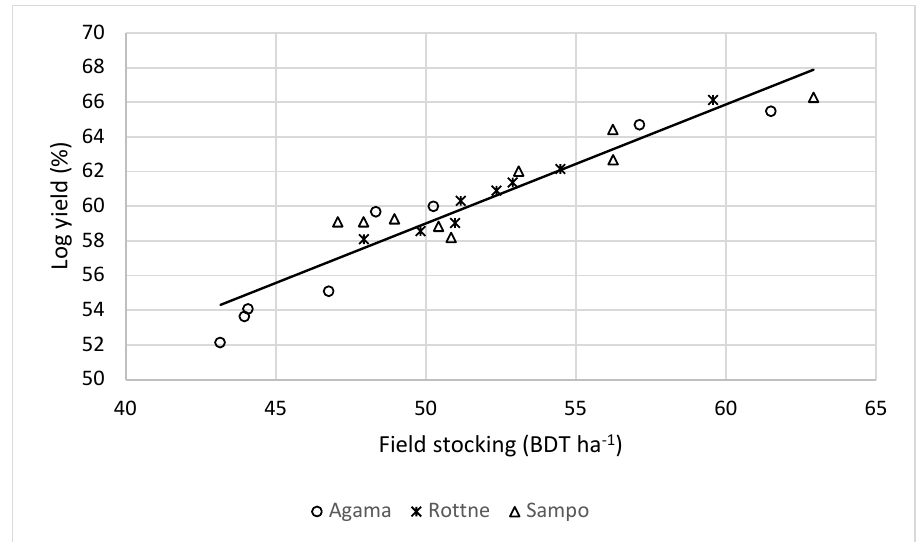
Figure 4. Log yield as a function of field stocking: point scatter and regression graphs (excluding Vimek chain).